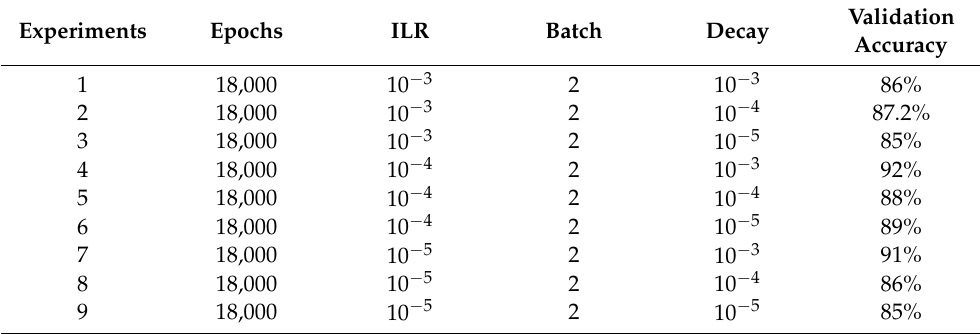
Table 3. Performance on different super parameter settings of the proposed